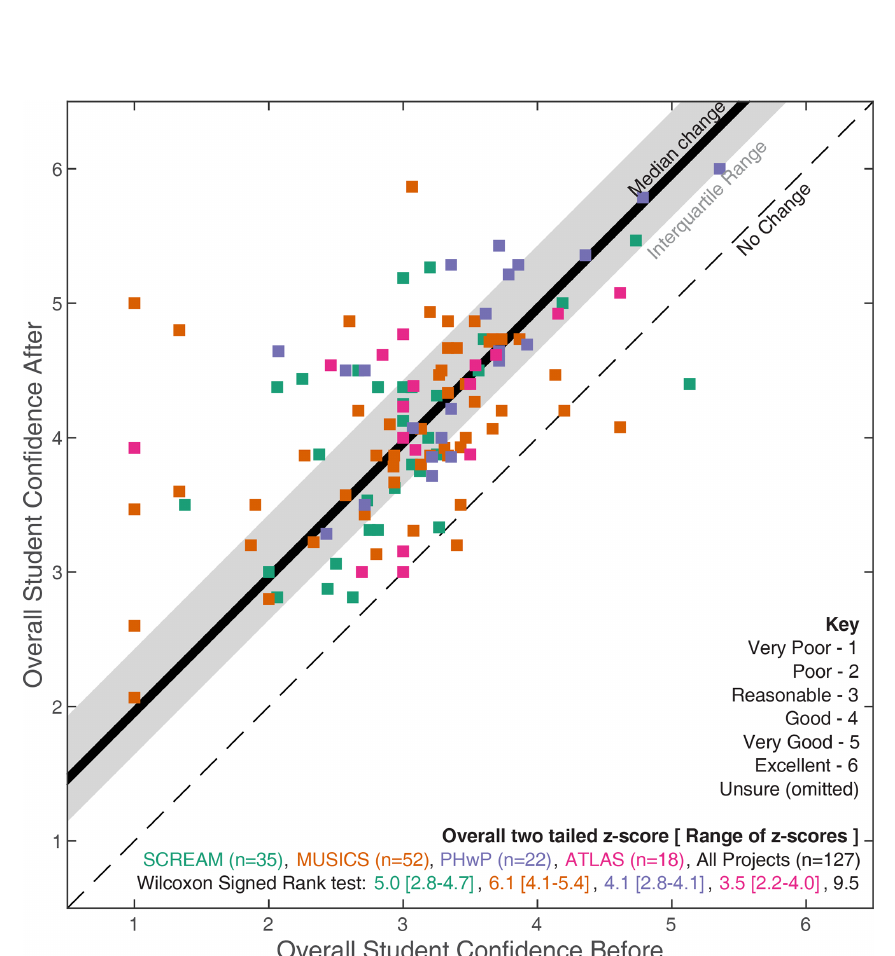
Figure 1. Overall student confidence in relevant scientific topics/methods before and after taking part in PRiSE ( n = 127). Data points are coloured by project. Overall changes are also indicated through the interquartile range (grey area) and standard confidence interval in median (black bar). Overall and ranges of z scores in two-tailed Wilcoxon signed-rank tests are also listed by